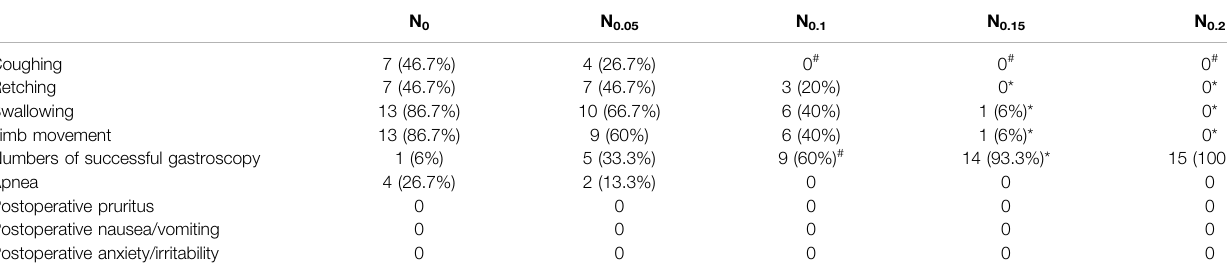
TABLE 2 | Comparison of intolerance indexes and successful gastroscopy incidences in fi ve